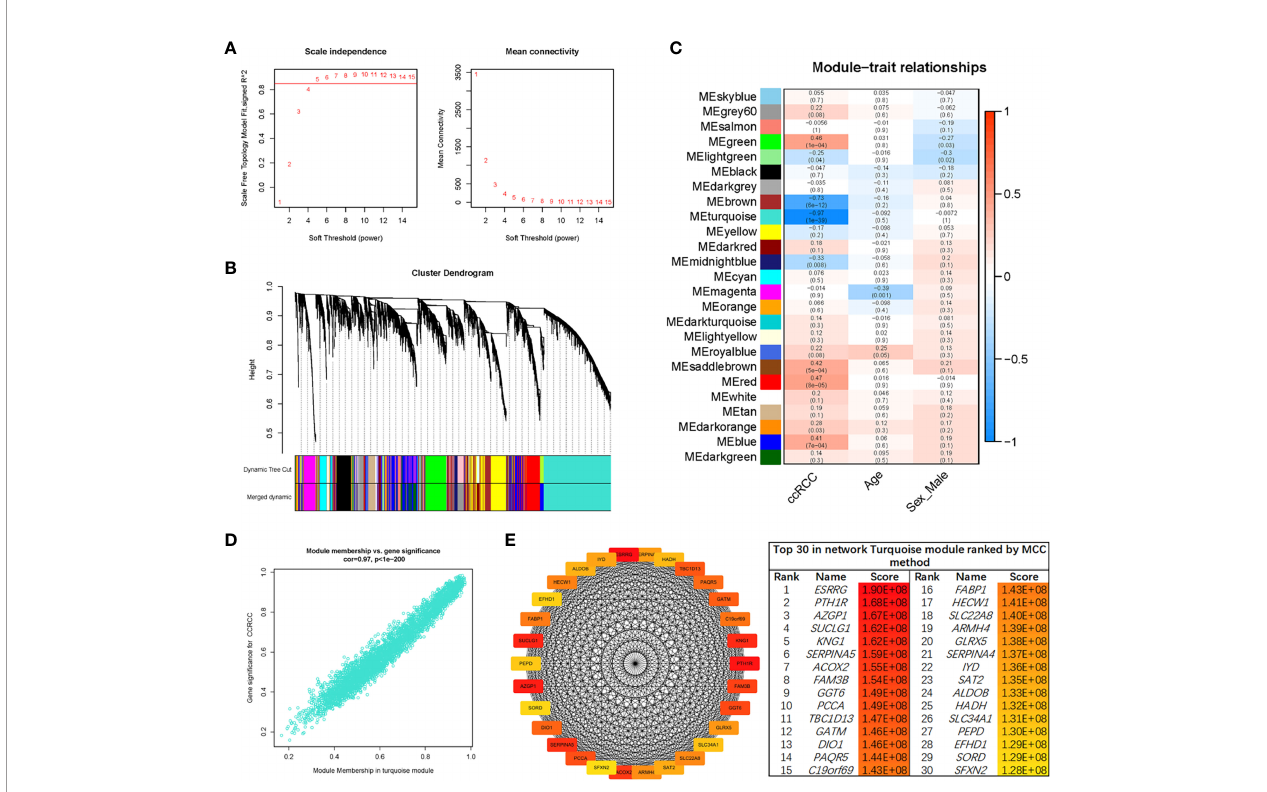
FIGURE 3 | WGCNA of the ccRCC samples. (A) Analysis of the network topology for various soft-thresholding powers. The left plot shows the scale-free fi t index (y-axis) as a function of the soft-thresholding power (x-axis). The horizontal red line shows x-axis = 0.85. The right plot displays the mean connectivity (degree, y-axis) as a function of the soft-thresholding power (x-axis). The power was set as 5 for further analysis. (B) Hierarchical cluster analysis was conducted to detect co- expression clusters with corresponding color assignments. Each color represents a module in the constructed gene co-expression network, as assessed via WGCNA. (C) Module – trait relationships. Each row represents a color module, and every column represents a clinical trait. Each cell contains the corresponding correlation and p-value. (D) A scatter plot of GS for ccRCC vs. the MM in the turquoise module. (E) Identi fi cation of hub genes using the MCC method. Genes with the top 30 MCC values were colored red to yellow. Red refers to a relatively large MCC value, and yellow refers to relatively smaller MCC values. WGCNA, weighted gene co-expression network analysis; ccRCC, clear cell renal cell carcinoma; GS, gene signi fi cance; MM, module membership; MCC, maximal clique